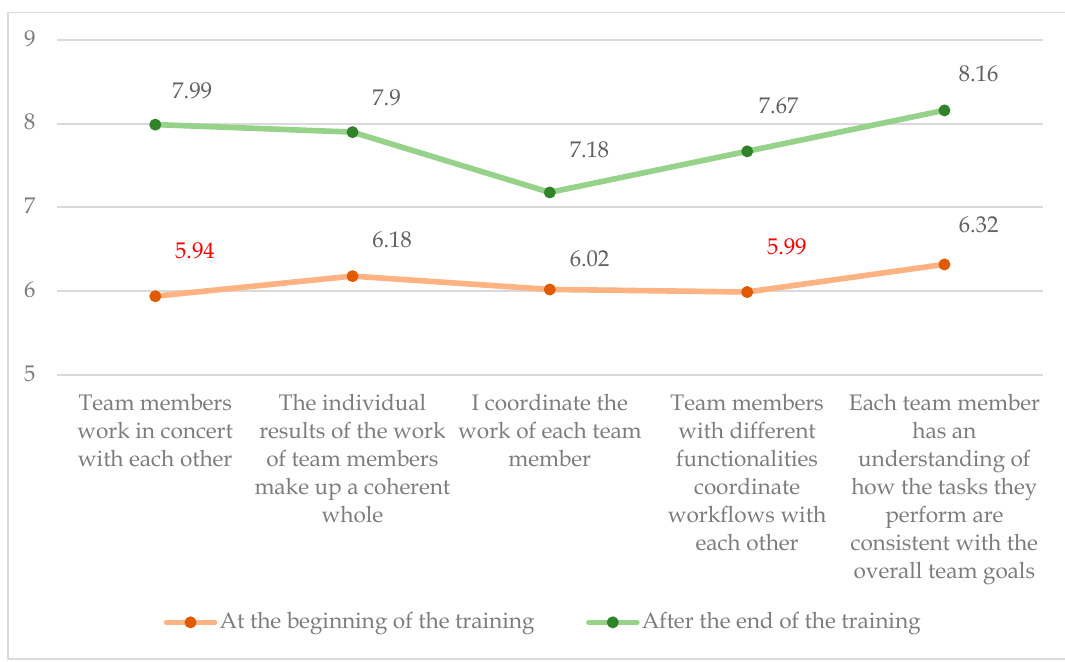
Figure 3. Results of answers to the block of questions “Formation of commitment to the overall result” (in comparison of answers to questions at the beginning and after the end of the training).